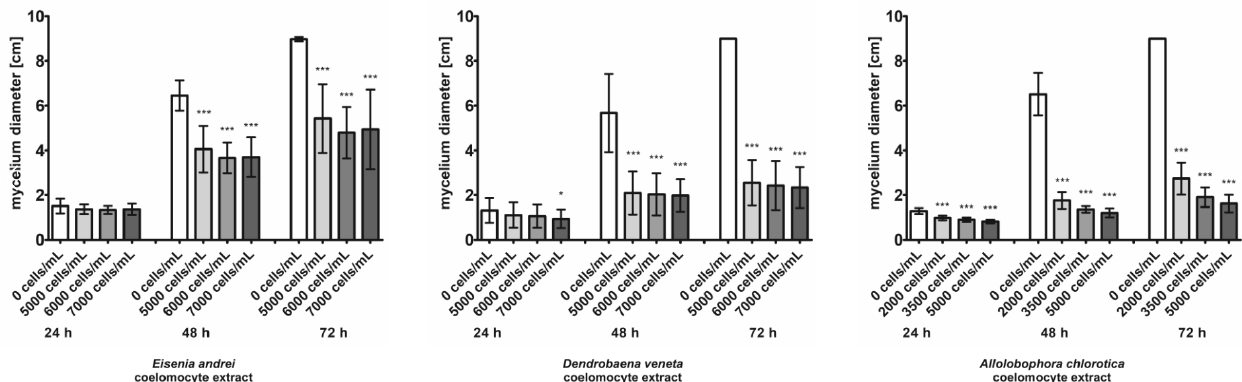
Figure 8. Growth (mean diameter ± SD) of Sclerotinia sclerotiorum mycelium 24, 48 and 72 h after treatment with Eisenia andrei , Dendrobaena veneta and Allolobophora chlorotica coelomic fluid extracts. Significant differences between control and groups treated with coelomocyte extracts are labeled with * ( p < 0.05), ** ( p < 0.01) and *** ( p <